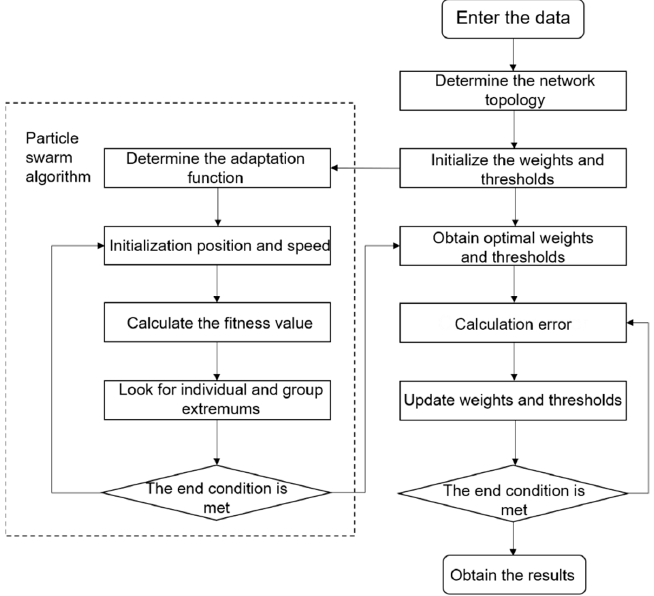
Figure 5. Flow chart of PSO-BP pressure drop model.